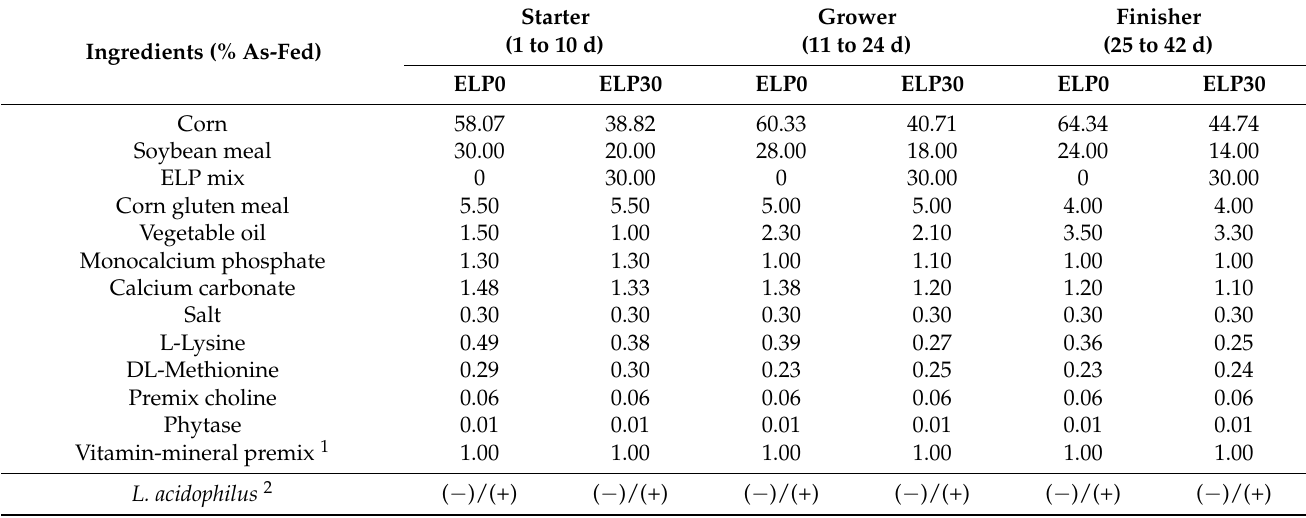
Table 1. Ingredients and chemical composition of broilers